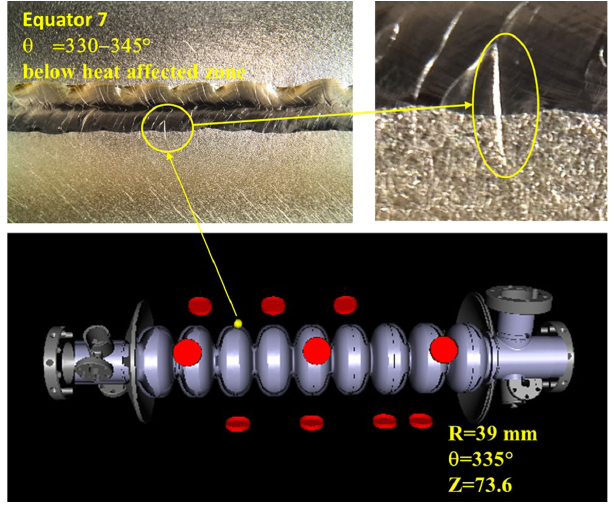
FIG. 5. Second sound quench reconstruction for cavity 3HZ021 (below) and optical image of the quench position (top left). On the top right, a magnification of the defect.